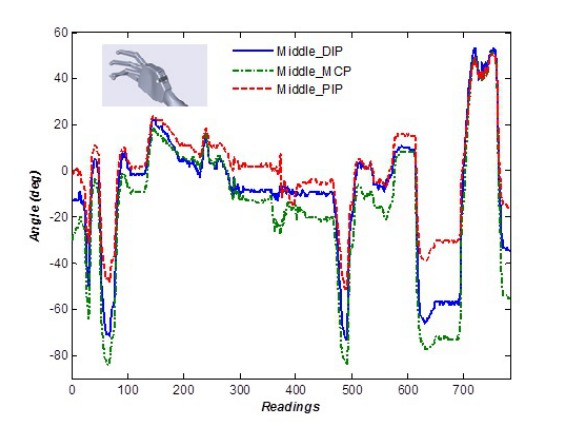
Figure 13: Middle finger rotation on DIP, MCP, and